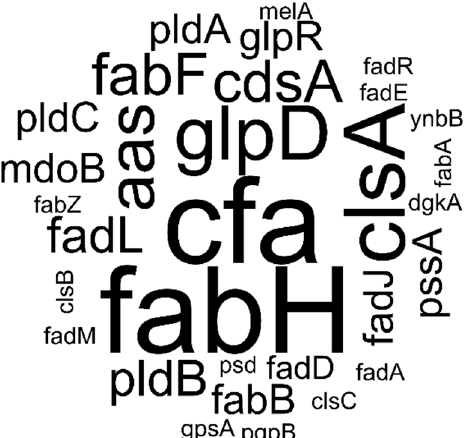
Figure 3. Tag cloud of the altered gene expression levels leading to extremes in marker lipid species identified by random forest analysis.